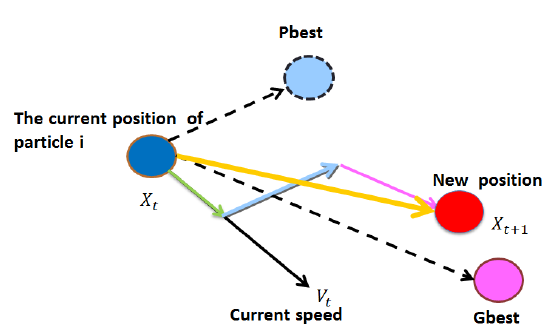
Figure 6. Search mechanism of